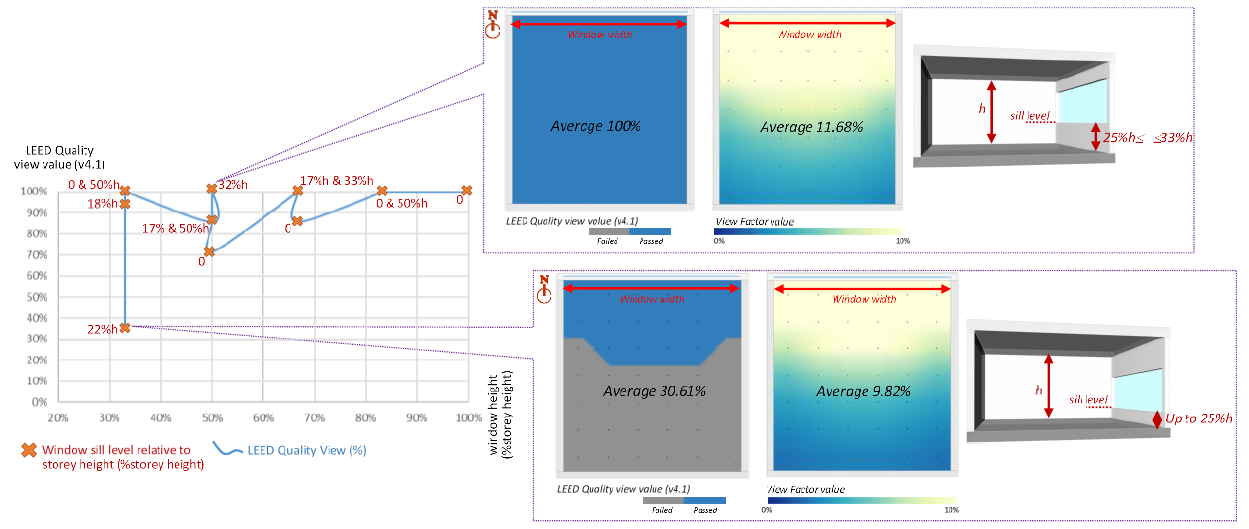
Figure 4. LEED quality view for different window lengths and sill levels for full-wide windows. A full-height window that is façade-centre-located can offer 100% view quality re- gardless of length except for W w < 20% L . A full-height window of 35% L < W w < 70% L can provide more than 96% view quality regardless of its transverse position relative to the façade. Therefore, a full-height window could be the best option in terms of view.